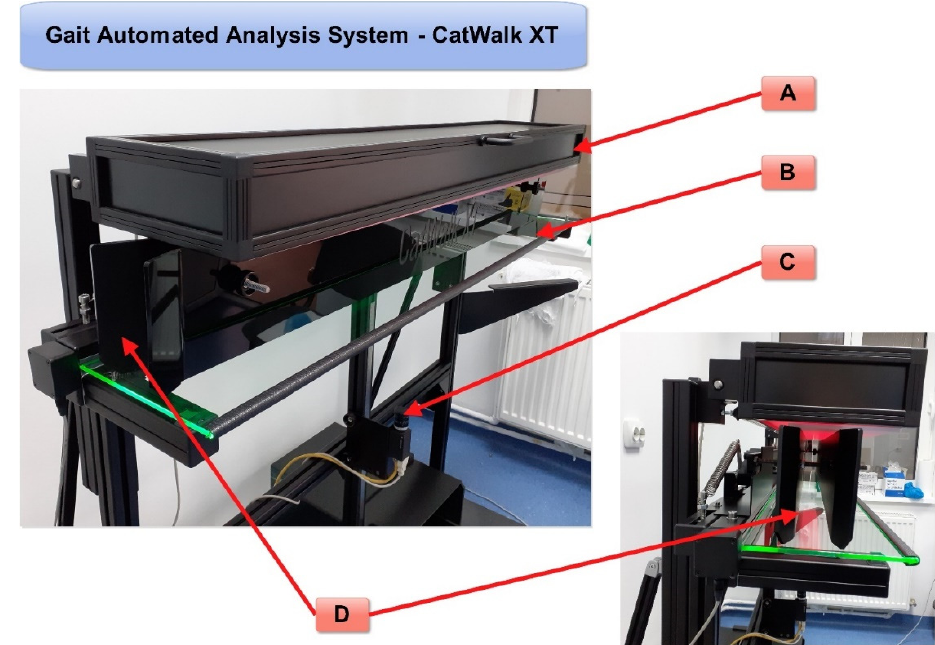
Figure 1. Automated gait analysis system—CatWalk XT: ( A )—red LED lights in the ceiling; ( B )—green LED lights along the walkway (reflected by the plantar surface of the rodent’s paw); ( C )—a high-speed color camera for accurate spatial and temporal resolution; ( D )—an adjustable corridor that directs the free movement of the rodents in a straight line with a glass walkway that enables CatWalk XT’s illuminated footprints technology (original photos).